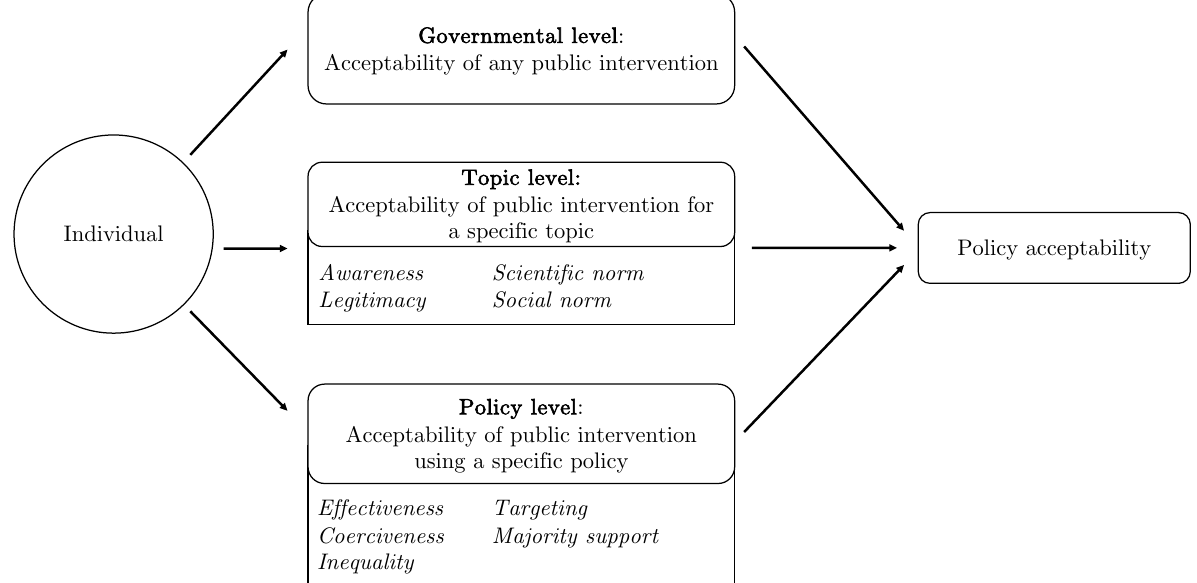
Figure 1. A model of food policy